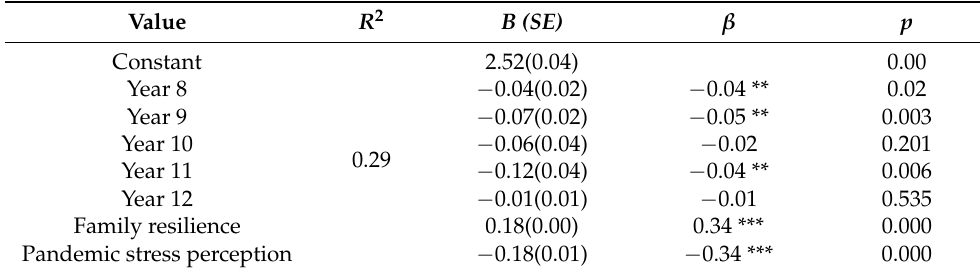
Table 8. Regression analysis ( N =